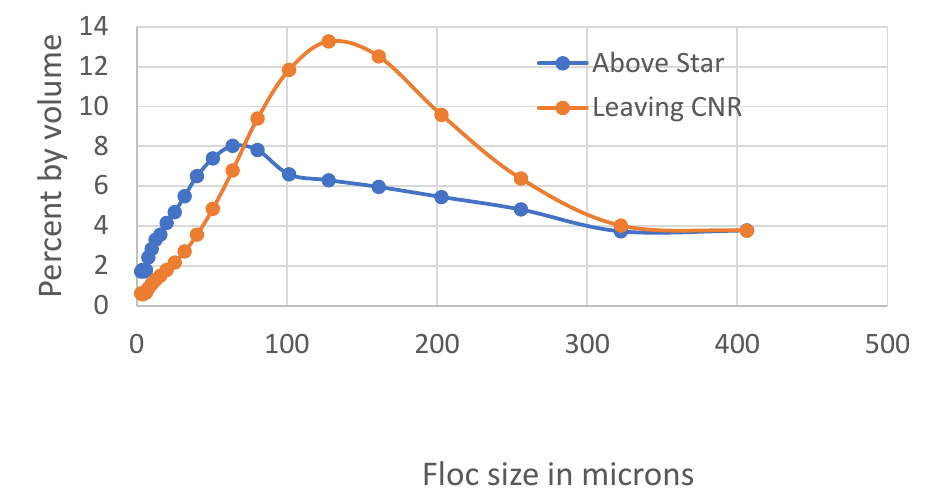
Above Star Leaving CNR